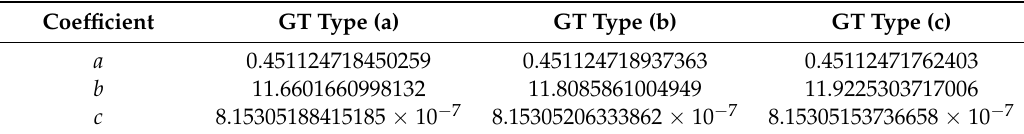
Table A1. Coefficients for Equation (A1).